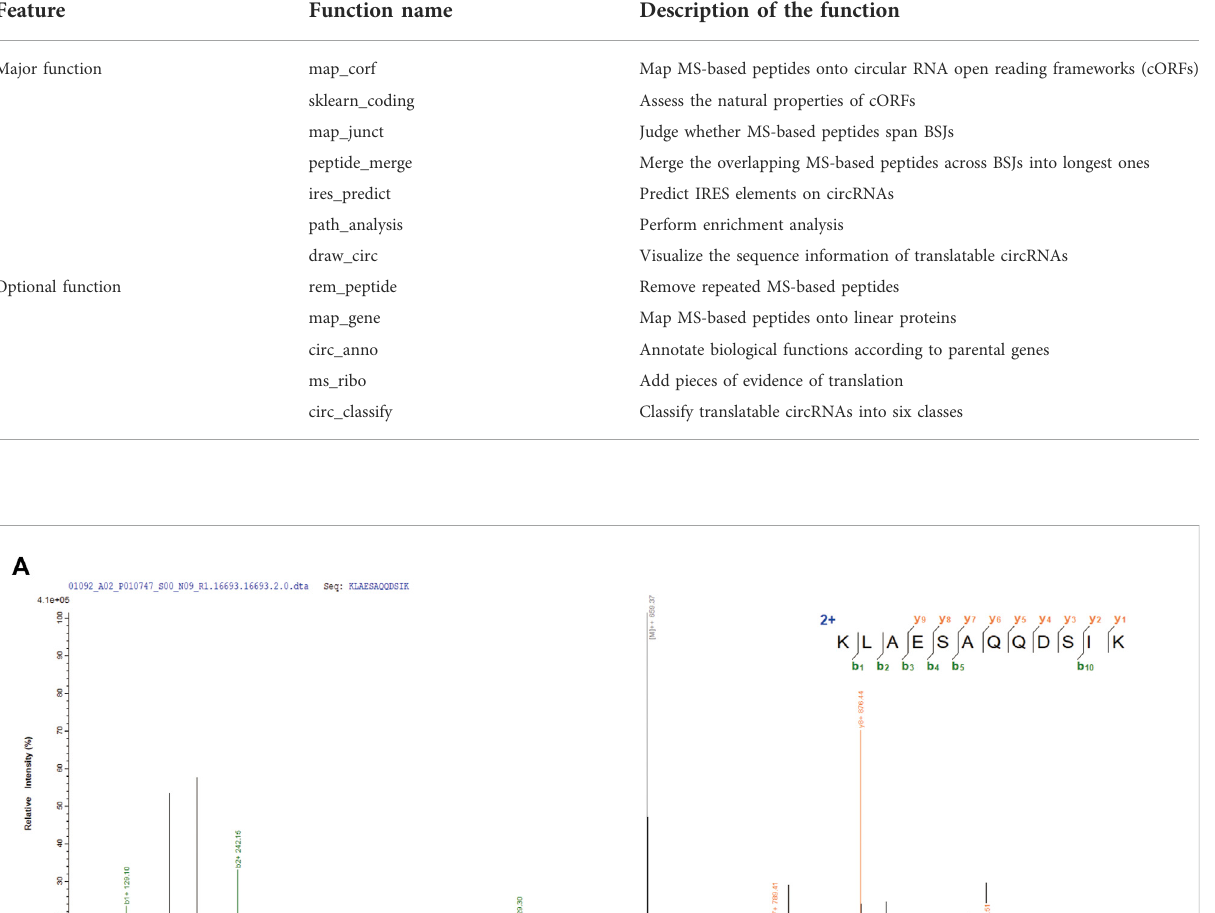
TABLE 1 Functional description of MStoCIRC.